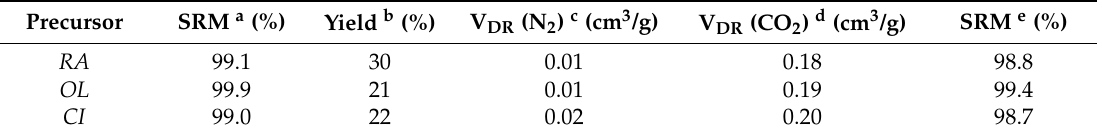
Table 2. Mechanical strength (expressed as the percentage of the remaining mass after sieving, SRM%, see Section 2.2.3.) of the natural seeds and carbonization yields, textural properties and mechanical strength (SRM%) of the materials after carbonization.